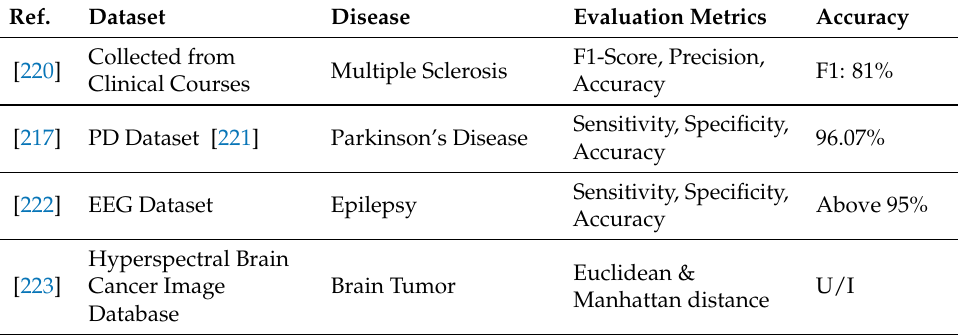
Table 10. KNN classifier result analysis on various NDs.